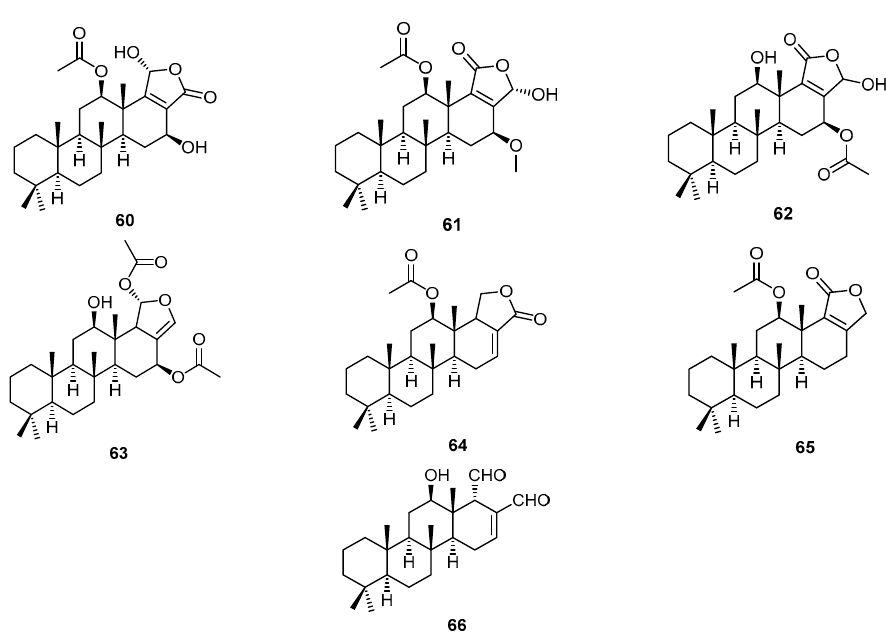
Figure 16. Chemical structures of 12-acetoxy,16- epi -hyrtiolide ( 60 ), 12 β -acetoxy,16 β -methoxy,20 α - hydroxy-17-scalaren-19,20-olide ( 61 ) and the sesterterpenes 62 – 66 .